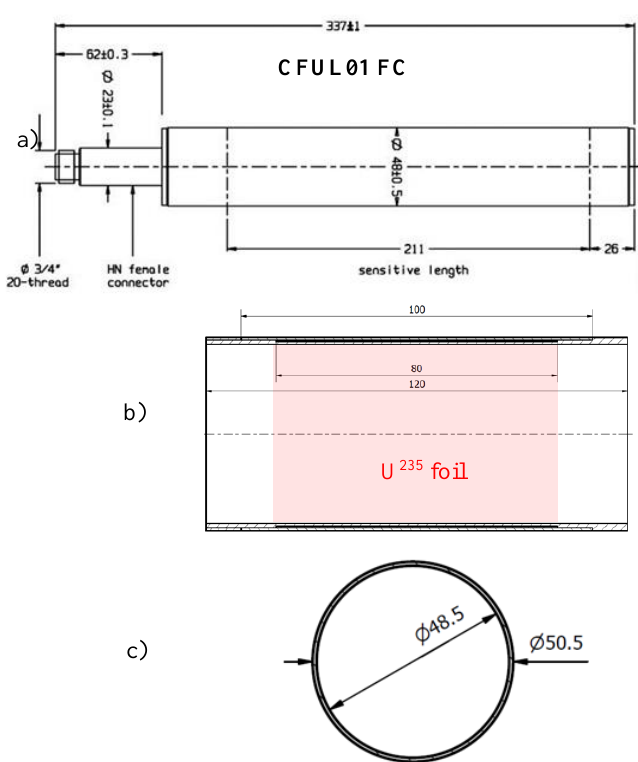
Fig. 2. The dimensions of the CFUL01 PHOTONIS FC (a) and the MARK-III U-235 90% convertor in vertical (b) and horizontal (c) view. The calculated coefficient K Meff-238 H,R was verified with additional measurements and calculations of fission rates in axial F28(H) and radial F28(R) directions of the MARK-III convertor. The results are in a good agreement (see Fig.3 and Fig.4). These results confirm the calculated coefficient K Meff- H,R . 238